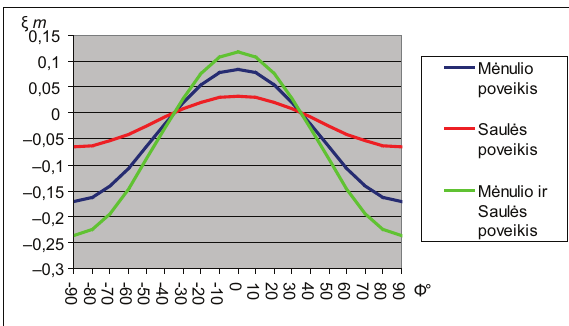
Fig. 4. Deformations of surfaces due to the Moon effect ( n = 4)